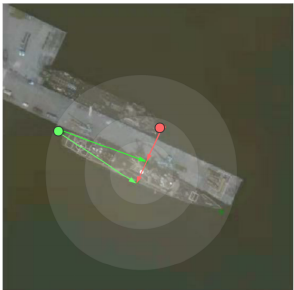
Figure 8. A special case that may fail to detect the ship instance represented by the green keypoints with our clustering algorithm if the ratio of λ 1 and λ 2 equals to 1.